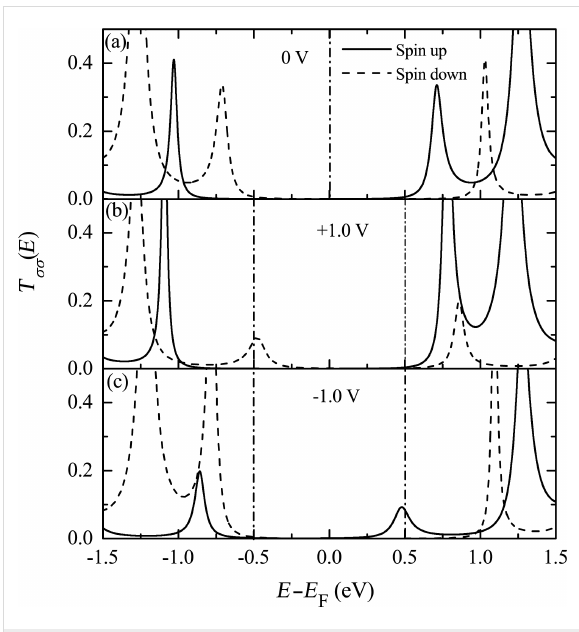
Figure 9: Spin-dependent transmission near the Fermi energy for N = 20 and E F = 0 at the bias voltages (a) 0 V, (b) +1.0 V, and (c) − 1.0 V. Reproduced with permission from [33], copyright 2008 AIP Publishing.